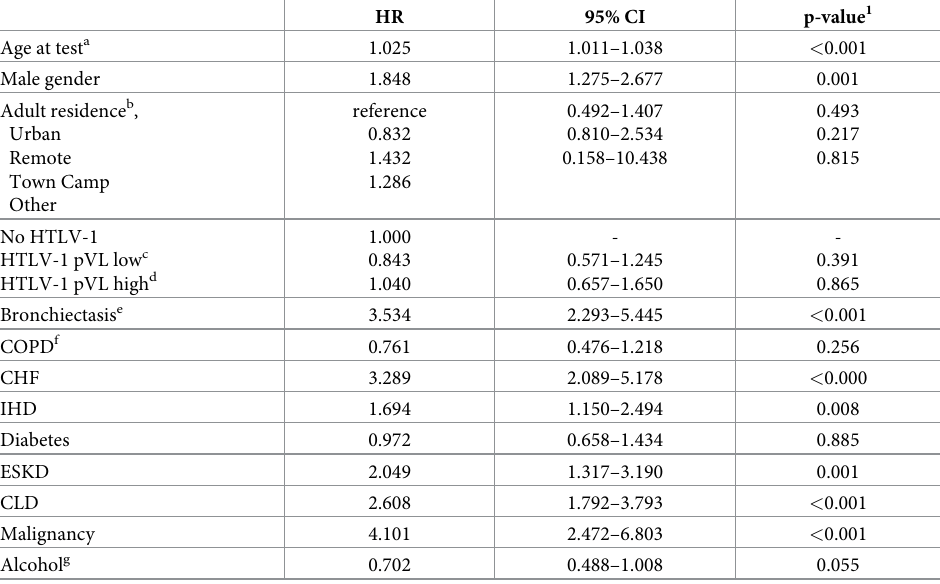
Table 5. Multivariate predictors of death among 840 Indigenous